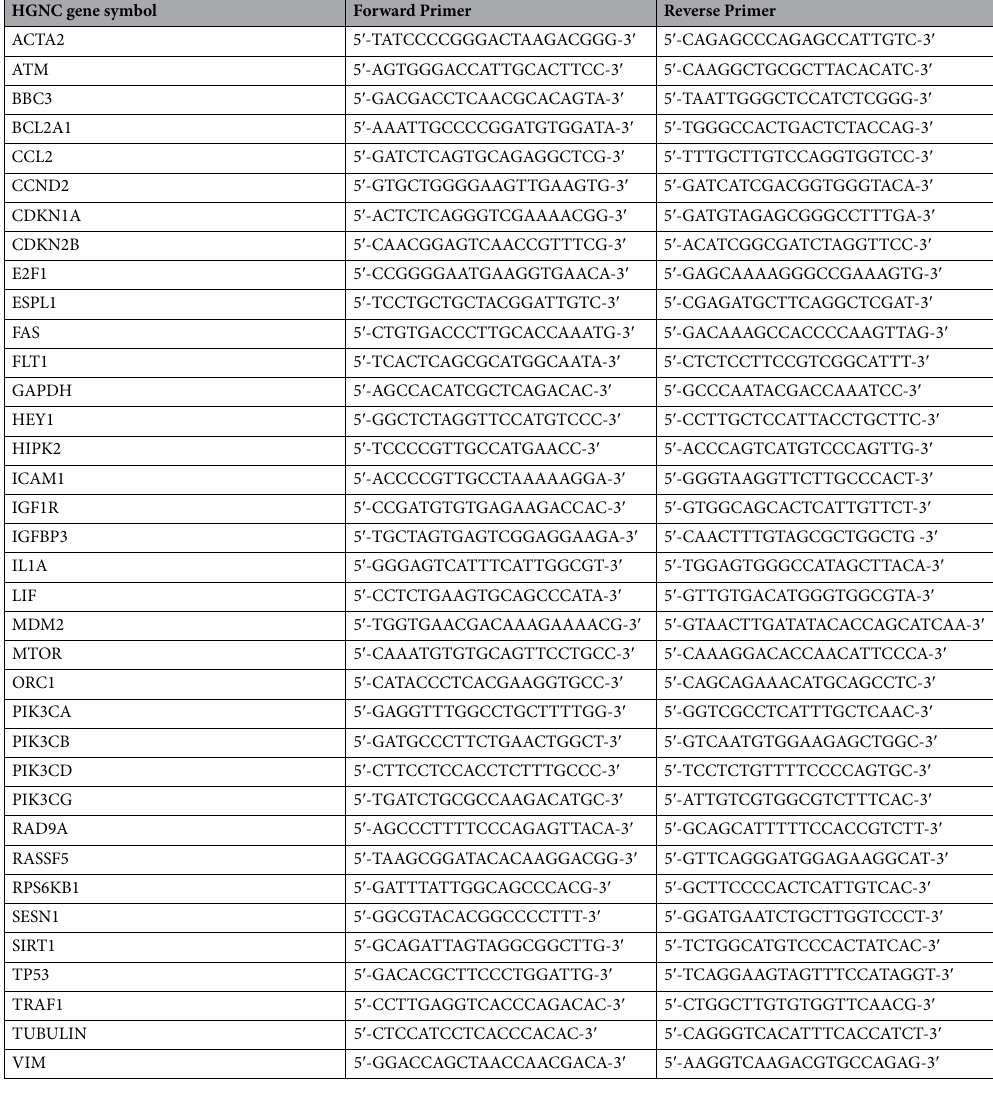
Table 1. Primers for